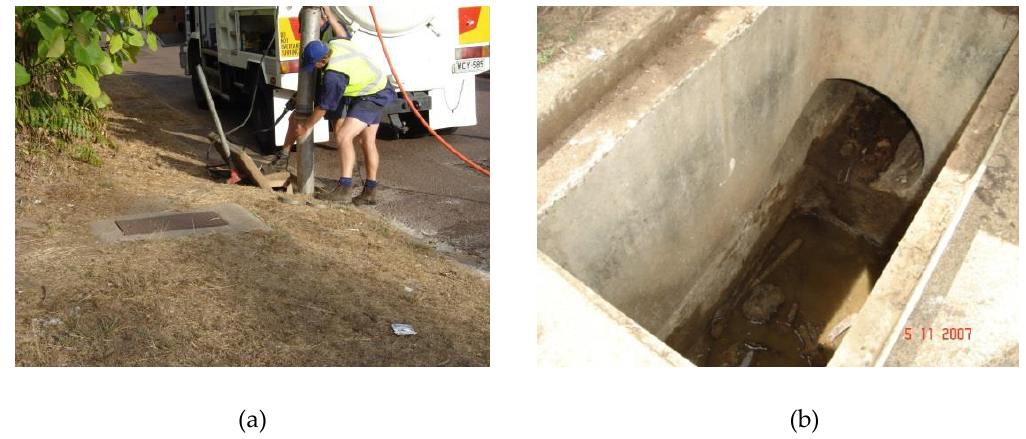
Figure 3. ( a ) Sump being cleaned by jet/vacuum; ( b ) cleaned sump ready for concrete